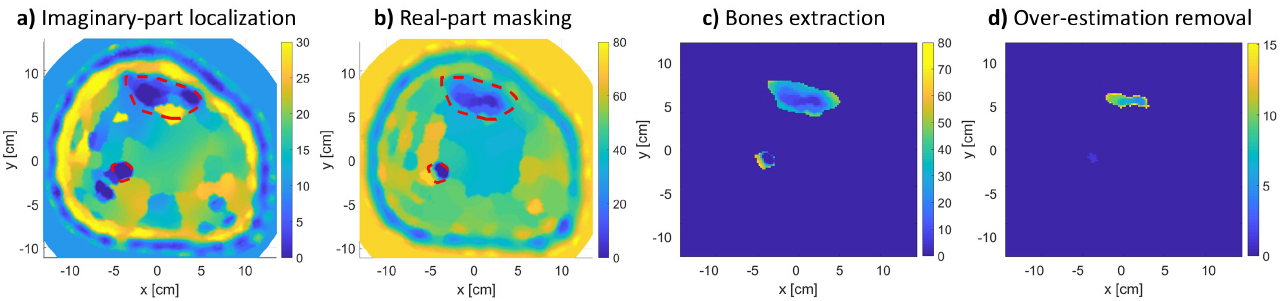
Figure 10. Expert-eye localization procedure followed to extract bone regions: ( a ) imaginary-part localization, ( b ) real-part masking, ( c ) extracted segments, and ( d ) over-estimated values removal.